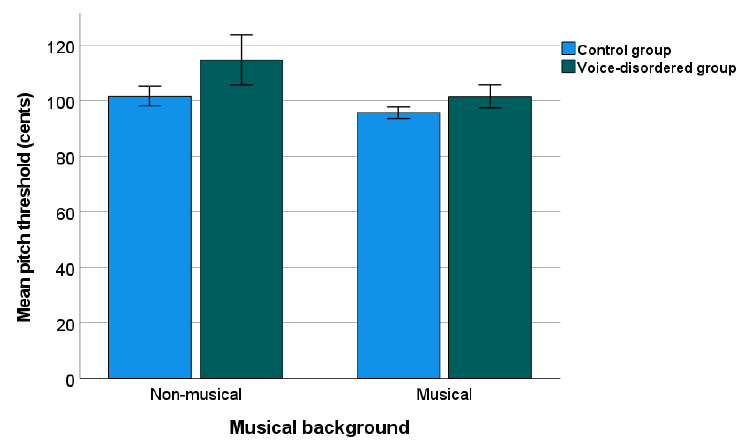
Figure 3. Pitch discrimination threshold in voice-disordered group and control group. Error bars indicate standard errors.